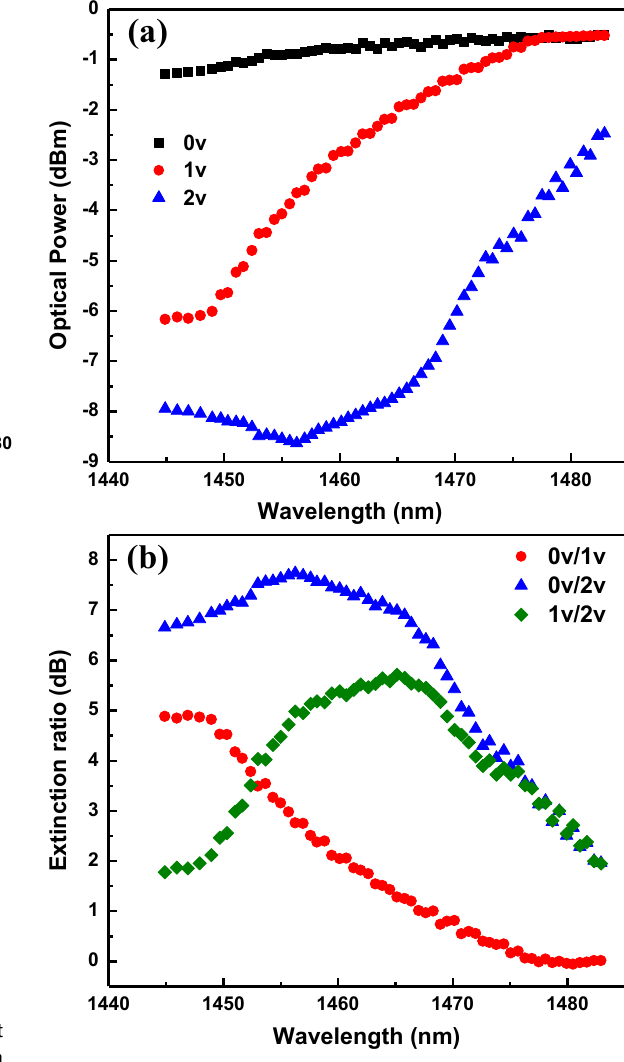
Figure 8: (a) Optical power spectrum under different bias voltages. (b) Extinction ratio of the device for different bias voltage